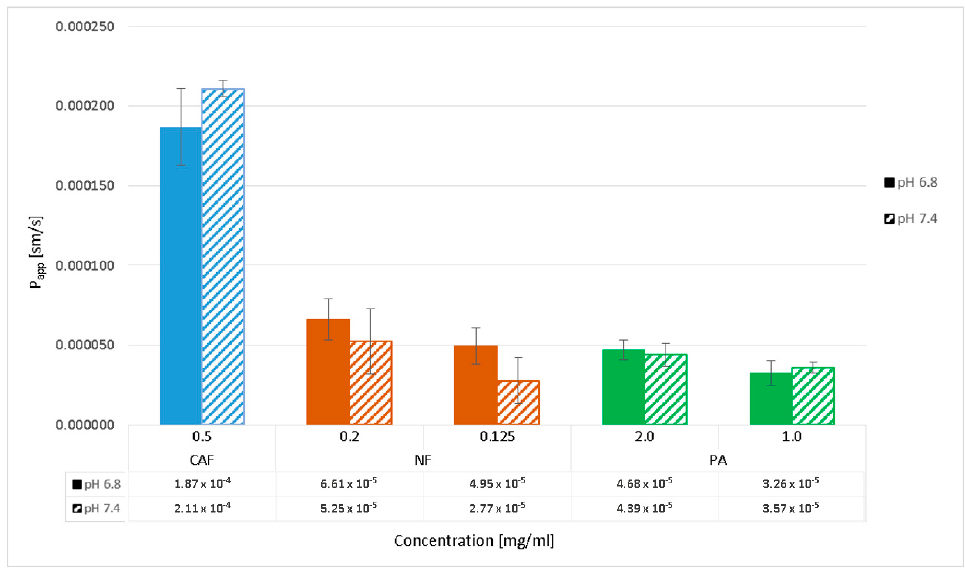
Figure 4. Apparent permeability coefficients (P app ) of perindopril arginine (PA), caffeine (CAF) and naftidrofuryl oxalate (NF) determined in the PermeaPad barrier in pH 6.8 and 7.4. Compounds’ transports were analyzed at the initial concentrations of 2.0 mg/mL and 1.5 mg/mL for PA, 0.5 mg/mL for CAF, and 0.2 mg/mL and 0.125 mg/mL for NF. Results are reported as an average and standard deviation ( n = 3).